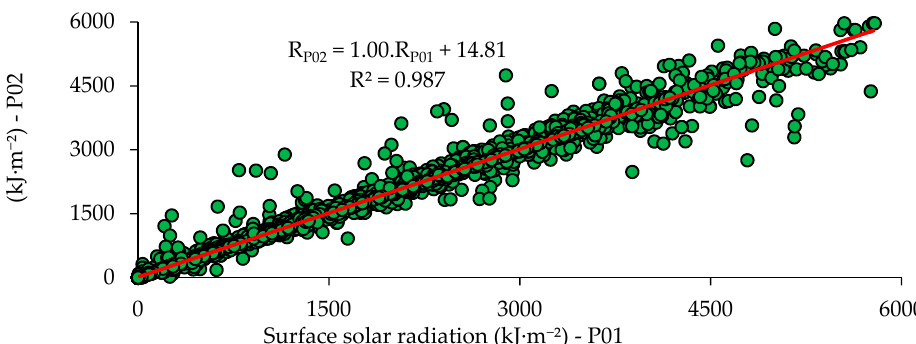
Surface solar radiation (kJ·m − ²) - P01 Figure 15. Scatter graph between the experimental results of prototype P01 and P02. The PDF function was used to model the differences between the official data and the experimental measurements (Figure 16). It identified the probability that the prototype’s response presented divergences within the range ( − 500 kJ·m − 2 ; 500 kJ·m − 2 ). Additionally, it estimated the probability of the prototypes presenting errors only within the specified range, keeping the uncertainties of measurements under those expected.